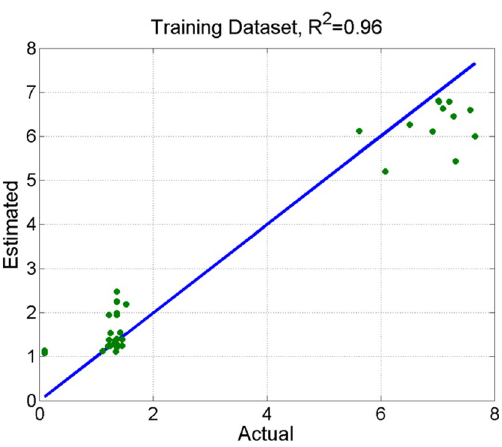
Figure 5. Verification scatter diagrams, with the x-axis showing the observed ethanol content and the y-axis presenting the estimated ethanol